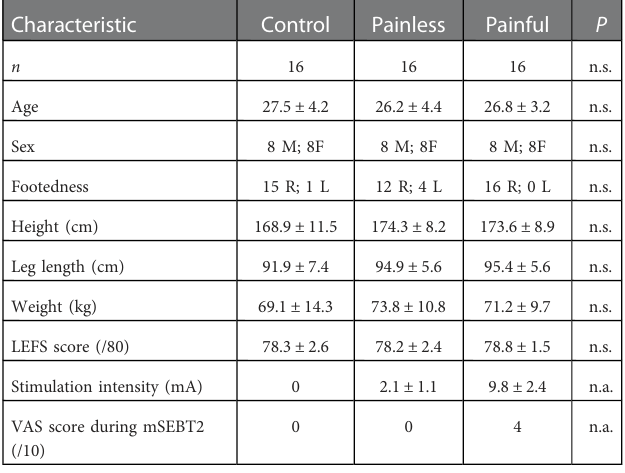
TABLE 1 Participants ’